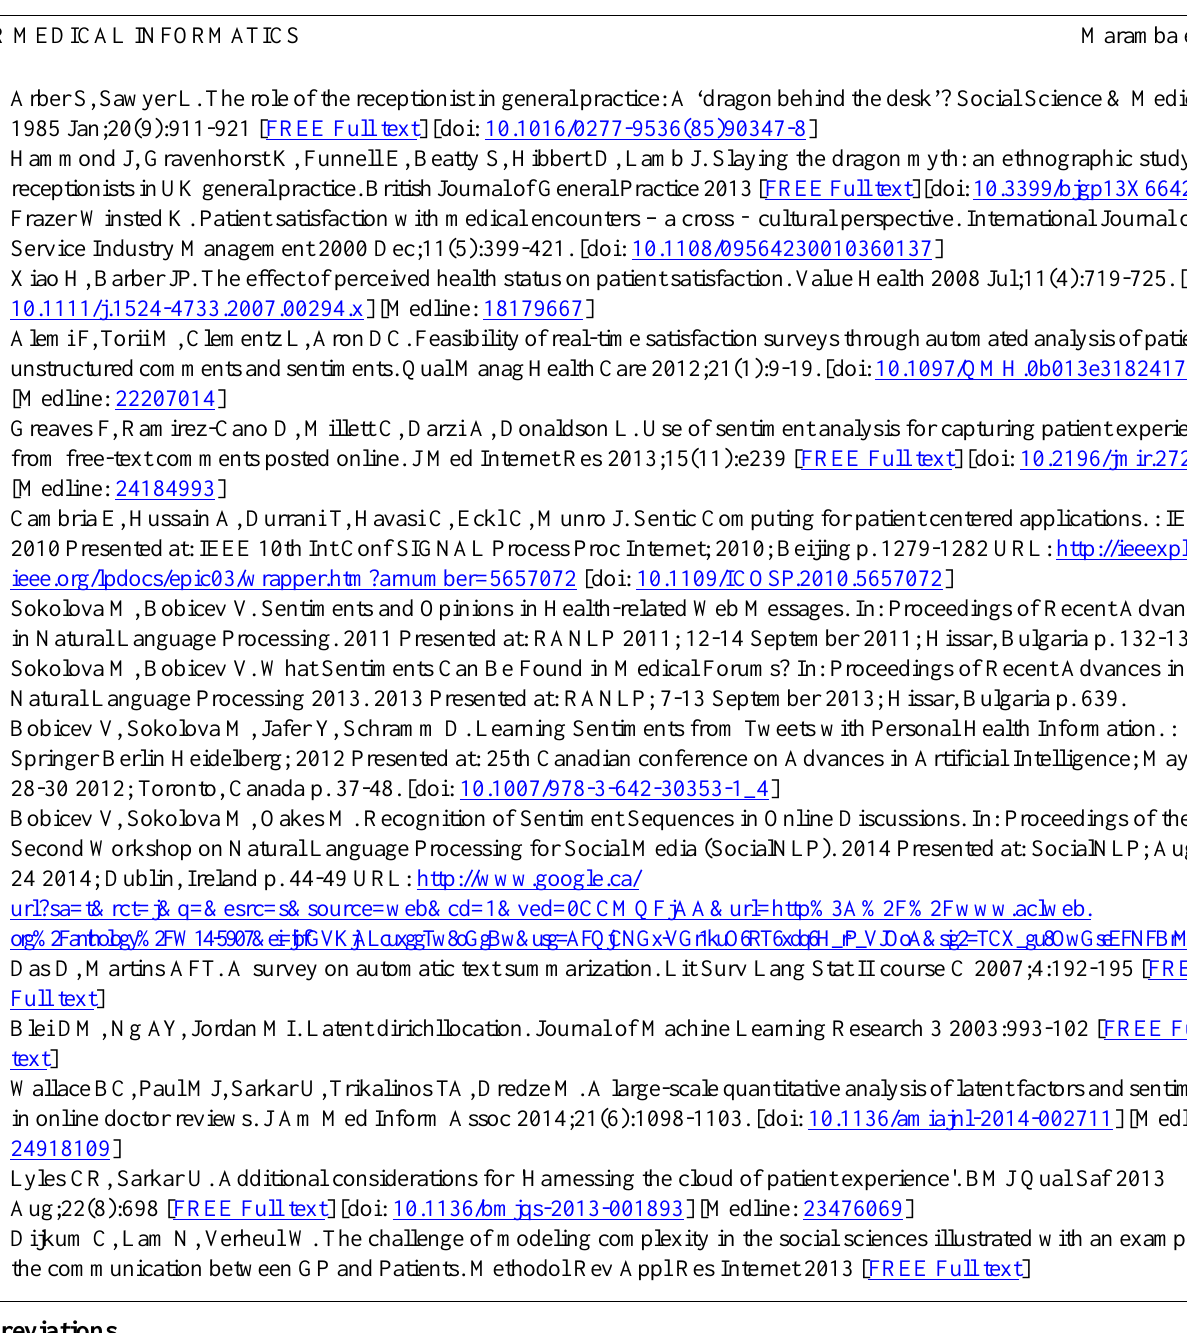
Abbreviations ASCII: American Standard Code for Information Interchange CI: confidence interval GPPS: General Practice Patient